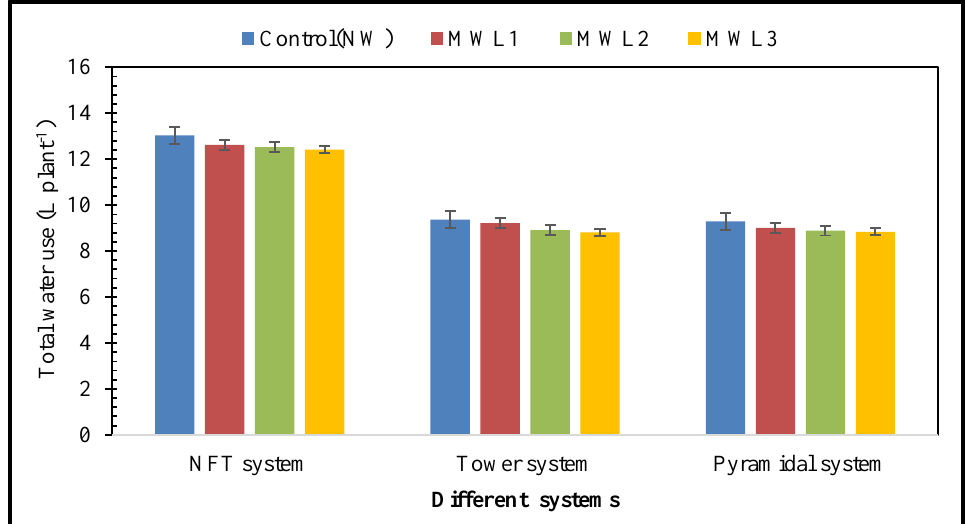
Figure 4. Total crop water used for different soilless culture systems under normal and magnetic water .LSD (0.05) = 8.82.